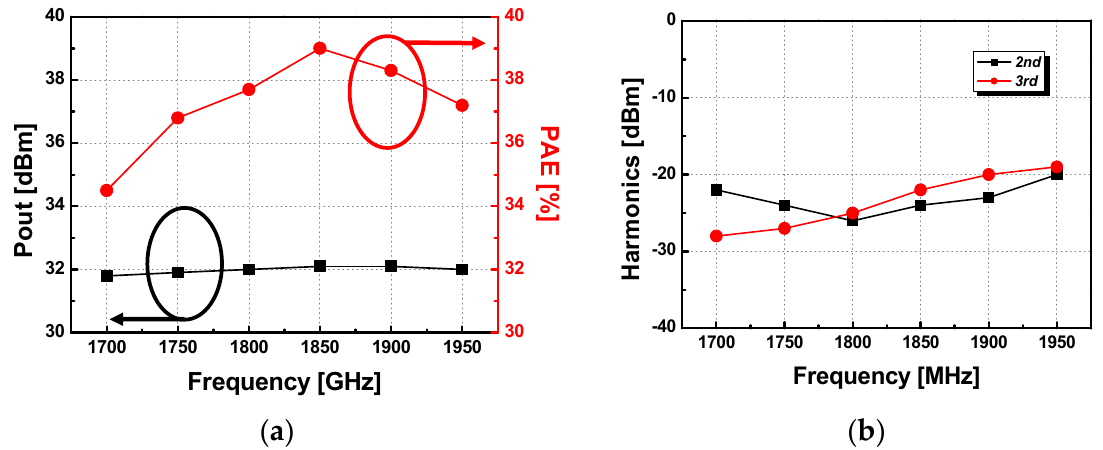
Figure 20. Measurement results. ( a ) Output power and PAE vs. frequency. ( b ) Harmonics vs. frequency.